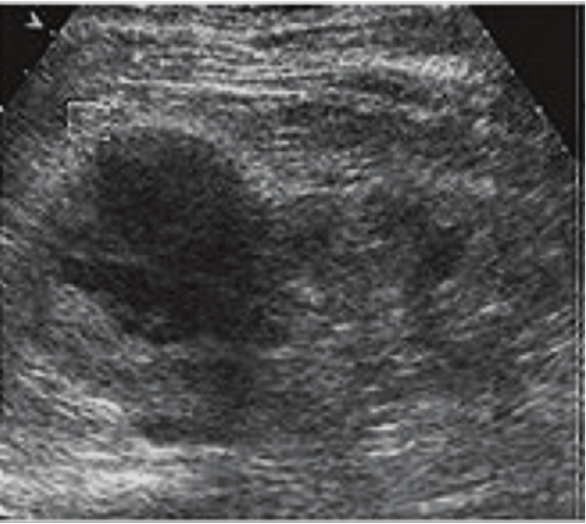
Figure 3 - Grayscale ultrasonography showing a suspected mass- mimicking lesion in the right kidney in a 53-year-old man with clear cell renal carcinoma.